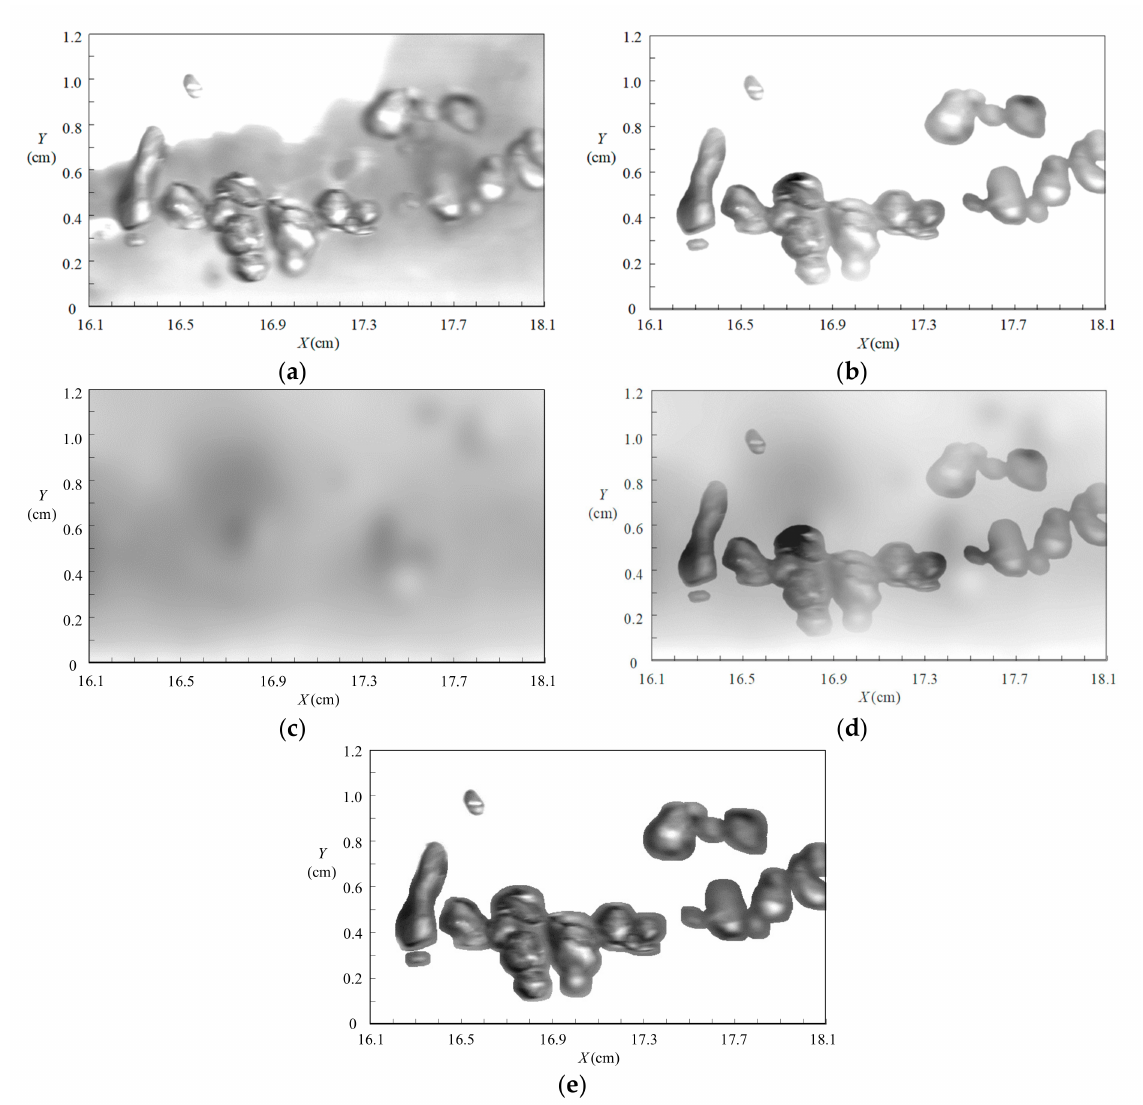
Figure 7. An example of the magnified image illustrating effective removal of the blurred-foreground: ( a ) Relatively clear image captured in the DOF mainly accompanied by the blurred-background image with fairly low gray level; ( b ) Clear air-bubble image captured in the DOF with the blurred background being removed; ( c ) Blurred-foreground image taken between the front glass wall and the center of the focal plane; ( d ) Superposed image consisting of the clear air-bubble ( b ) and the blurred-foreground ( c ) images; ( e ) The image left behind with removal of the blurred foreground via the image processing steps employed for Figure 6a–l, demonstrating this image is nearly the same as that shown in ( b